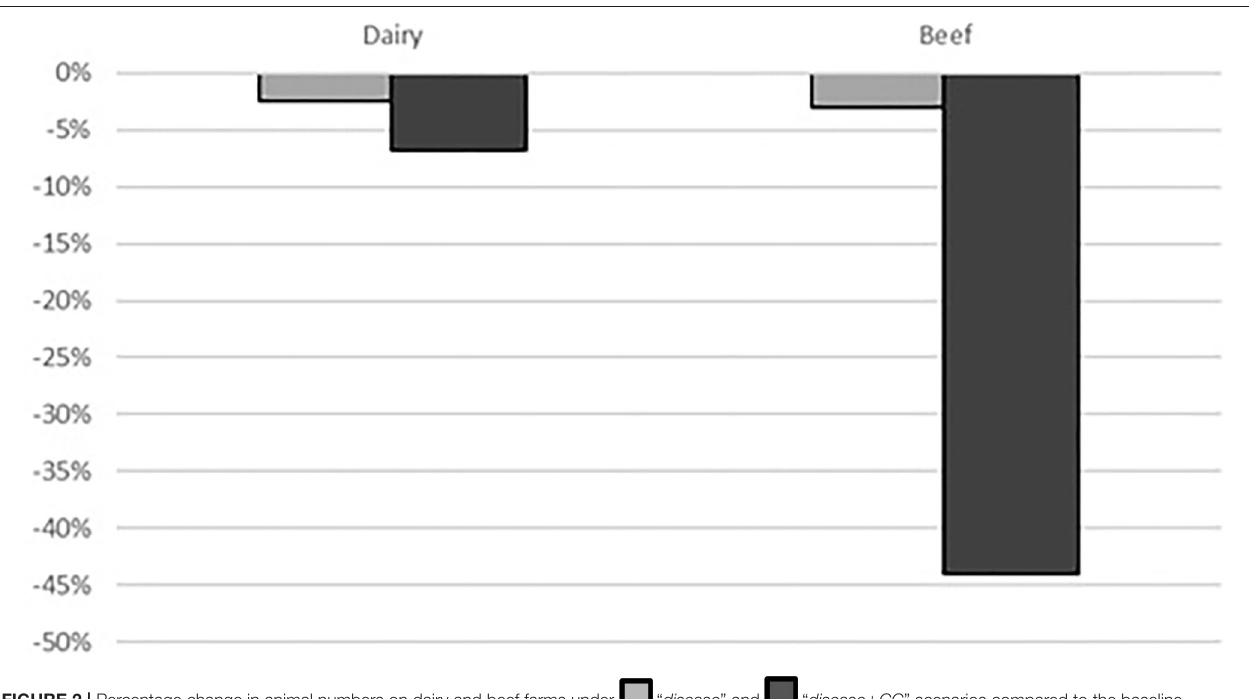
FIGURE 2 | Percentage change in animal numbers on dairy and beef farms under “ disease ” and “ disease + CC ” scenarios compared to the baseline scenario (y-axis represents percentage).